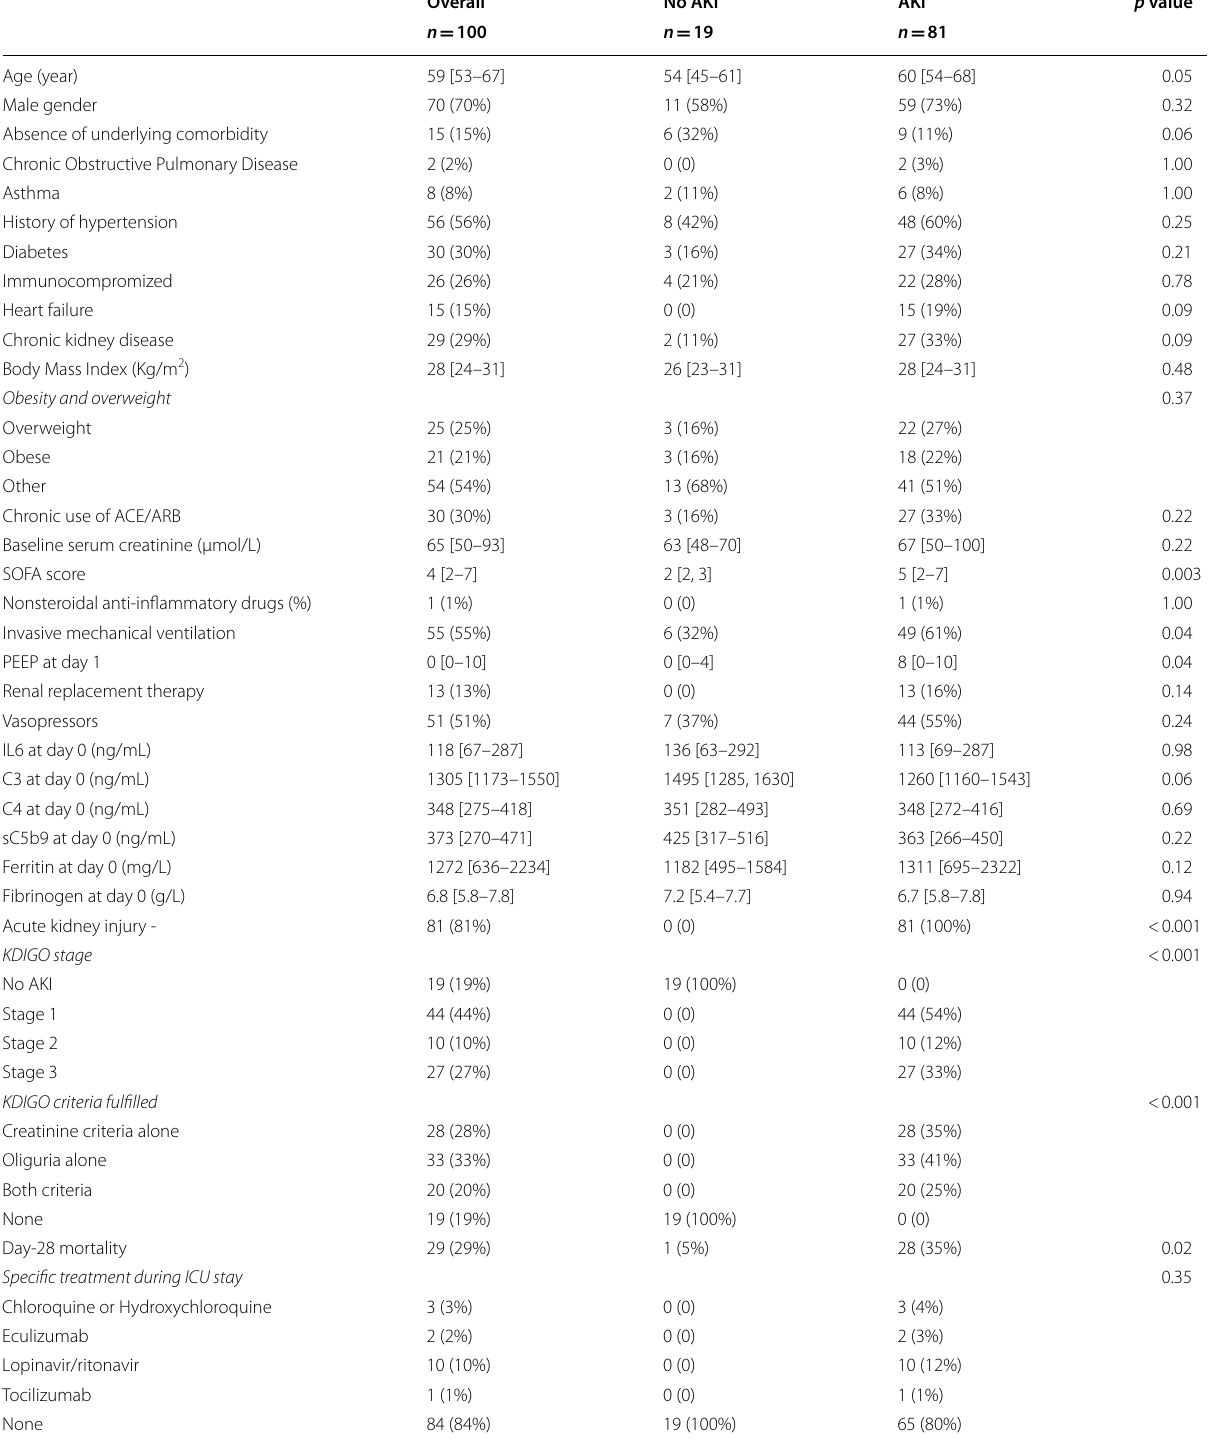
Table 1 Patients’ characteristics according to